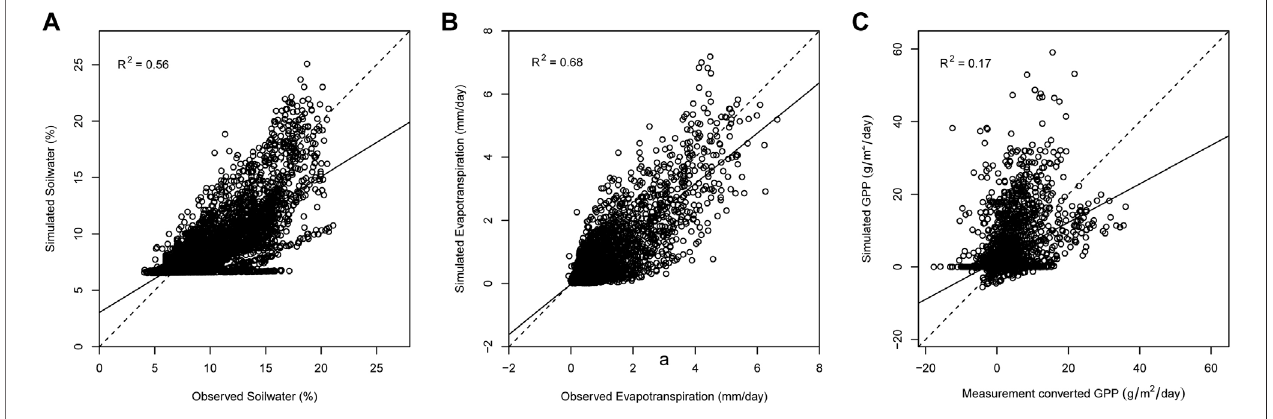
FIGURE 5 | Scatters of simulated and measured ET (A) , SW (B) and GPP (C) .